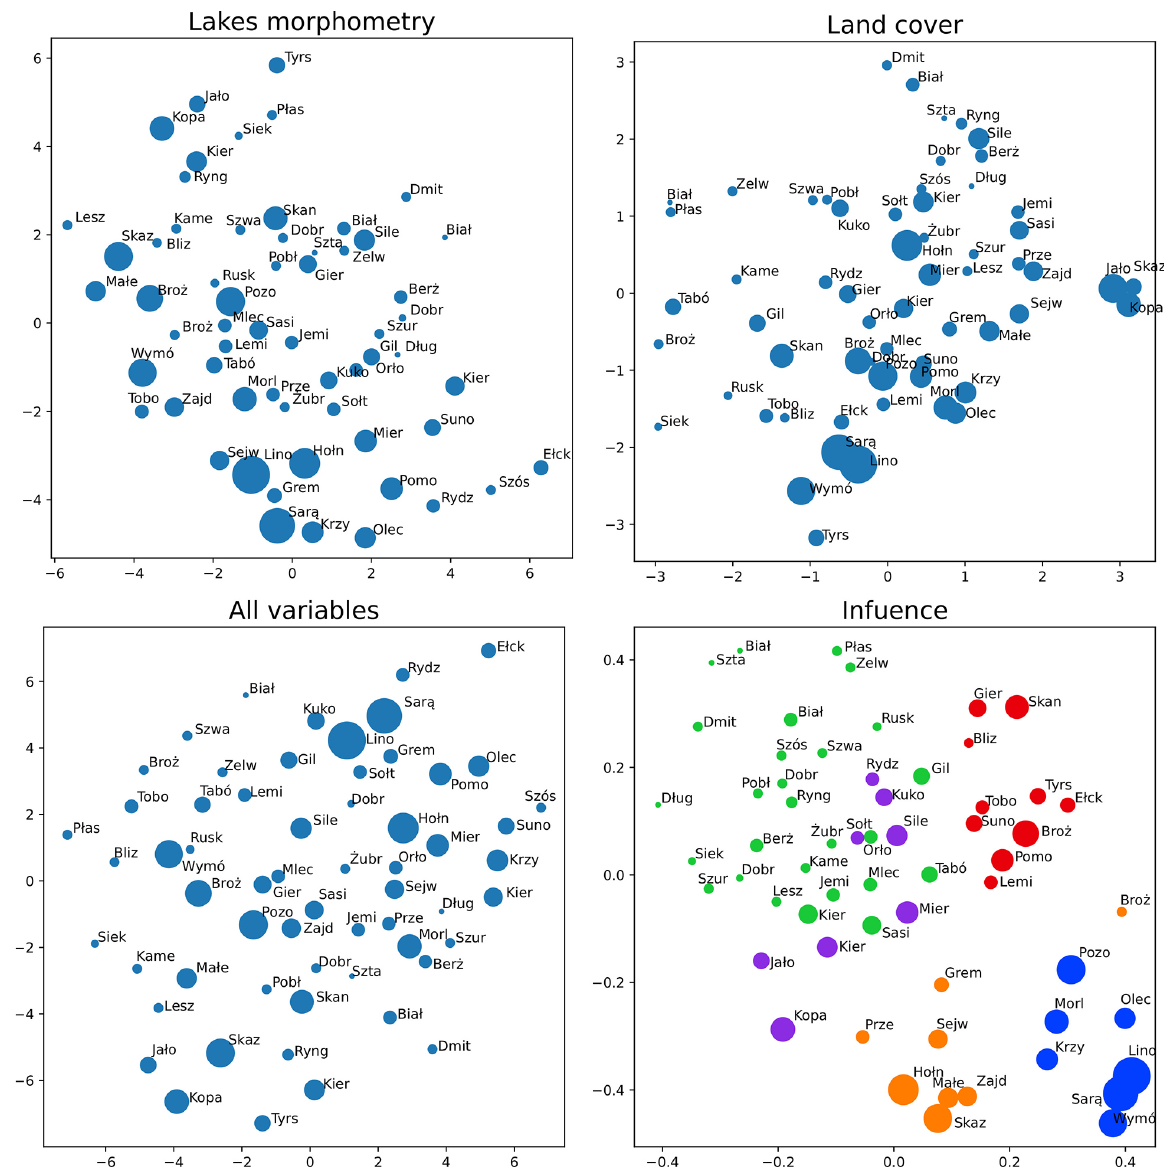
Fig. 11. Visualisation of dissimilarities between lakes in a form of MDS (multidimensional scaling). The axes of the plot have no units. Lakes morphometry presents dissimilarity for a group of morphometric features (see Table 1); Land cover presents dissimilarity for four land cover variables (urbanised, agriculture, forests, wetlands); ‘All variables’ plate uses all 25 variables; Influence presents dissimilarity between lakes in a space of variables influence. For colours see Figure